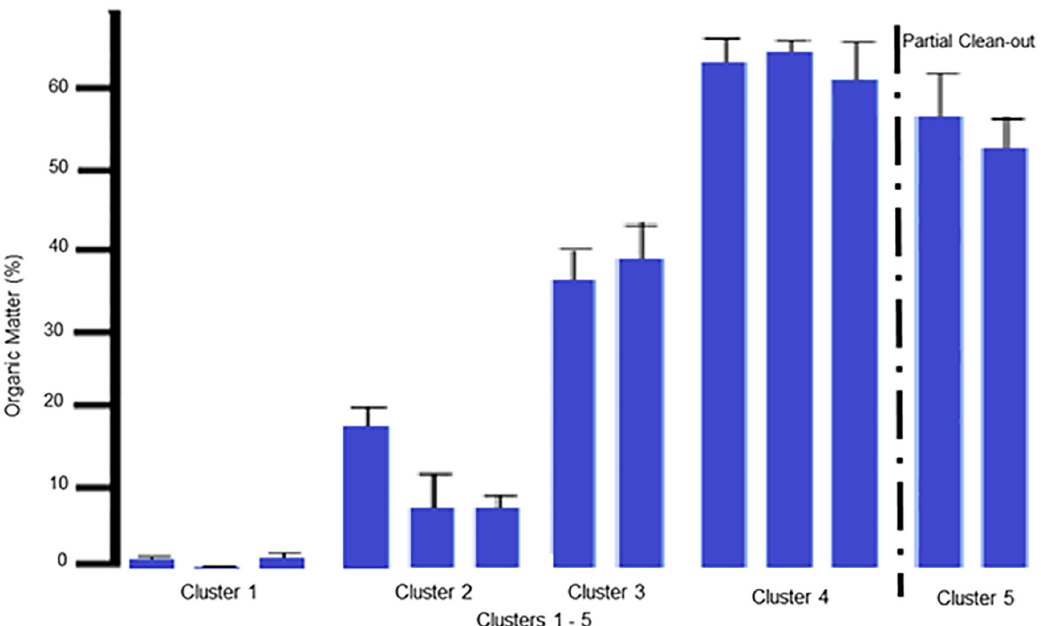
Fig 7. Mean values for Organic Matter. Mean values for Organic Matter, expressed as a percentage, with standard deviation error bars are shown in the bottom graph. In order from left to right on the graph is Cluster 1: Native, Pad and Flock1; Cluster 2: Flock 2, 10 and 11; Cluster 3: Flocks 3 and 4; Cluster 4: Flocks 5, 6, and 7; and Cluster 5: Flocks 8 and 9. The partial clean-out which occurred between Flock 7 and 8 is marked by a dashed line.